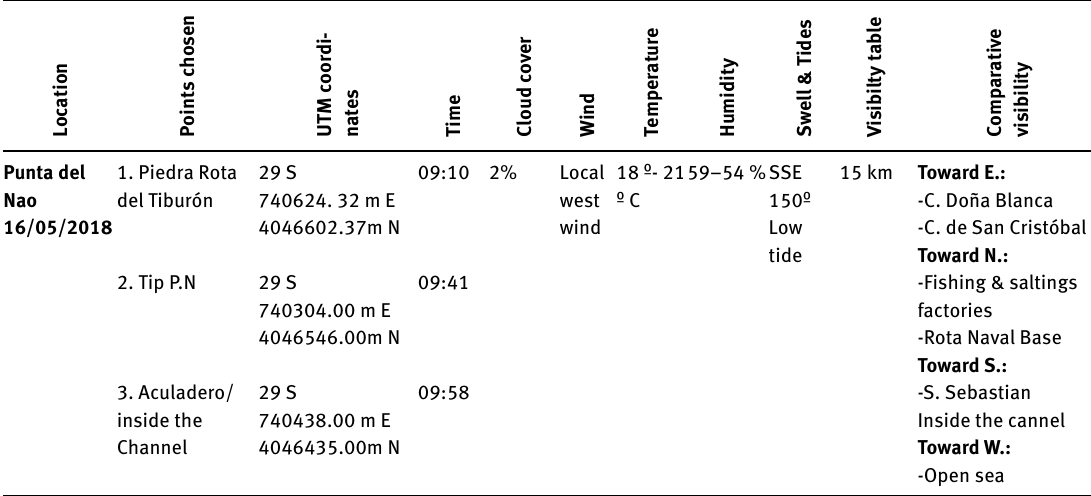
Table 3. Visibility study at the Punta del